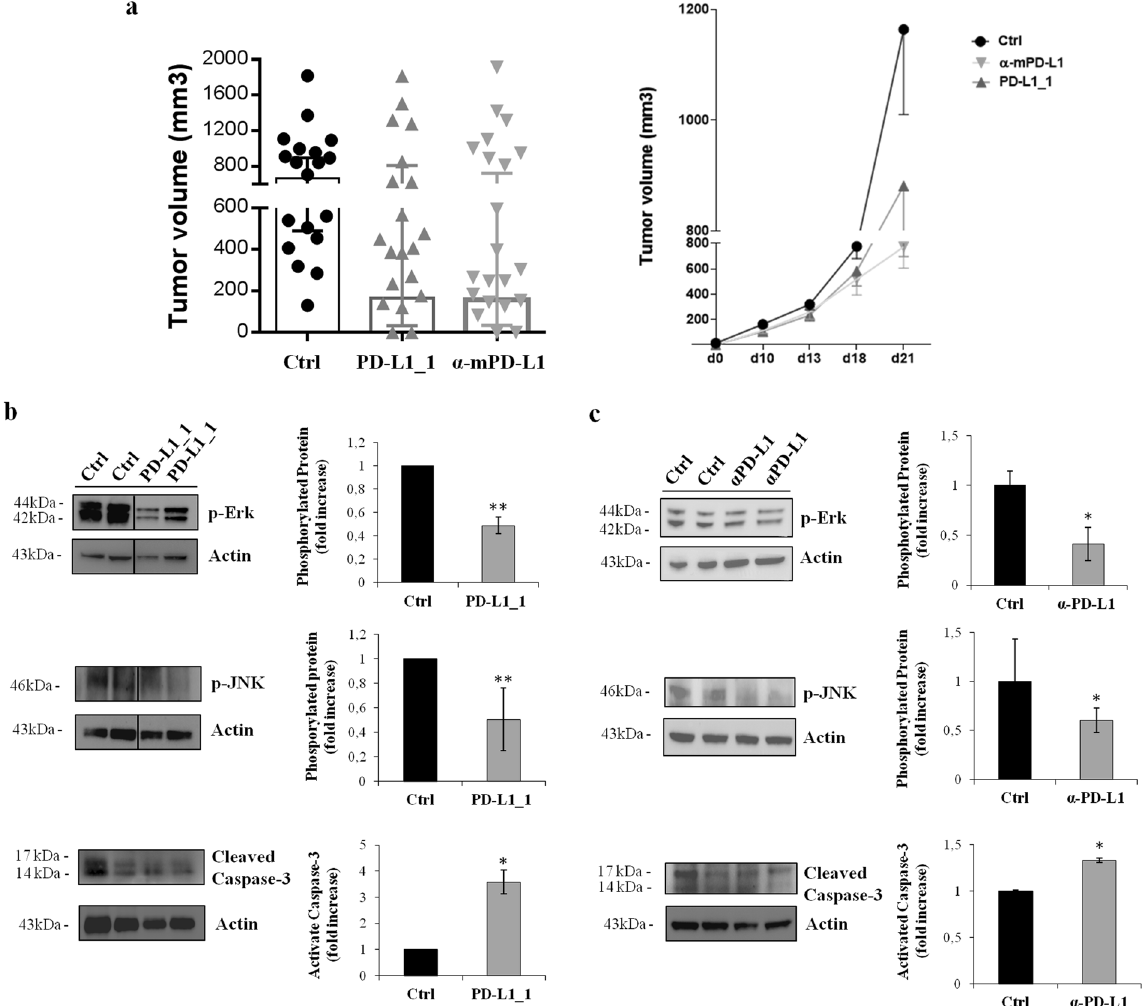
Figure 6. Effects of anti-PDL1 mAbs on tumor growth and signal transduction in CT26 tumors in vivo . ( a ) Tumor growth in mice inoculated sc with CT26 cells at day 0 and left untreated (black) or treated with PD- L1_1 (grey) or α -mPD-L1 (light grey). Shown is tumor volume for individual mice (n = 20) at day 21 (left panel) and mean of tumor volume for each group over time (right panel), * p = 0.02. Western blotting was performed on cell extracts from tumor specimens of two mice killed on day 21 from untreated groups or from responder groups treated with PD-L1_1 ( b ) or with α -mPD-L1 ( c ), as described in Methods. A line has been inserted to indicate distant lanes of the same gel (see Supplementary dataset). Protein levels are also expressed as fold increase with respect to those observed in untreated mice and normalized to actin. Error bars depicted means ± SD. P values for the indicated mAbs relative to cell extracts from untreated groups, are: *** P ≤ 0.001; ** P < 0.01; * P <